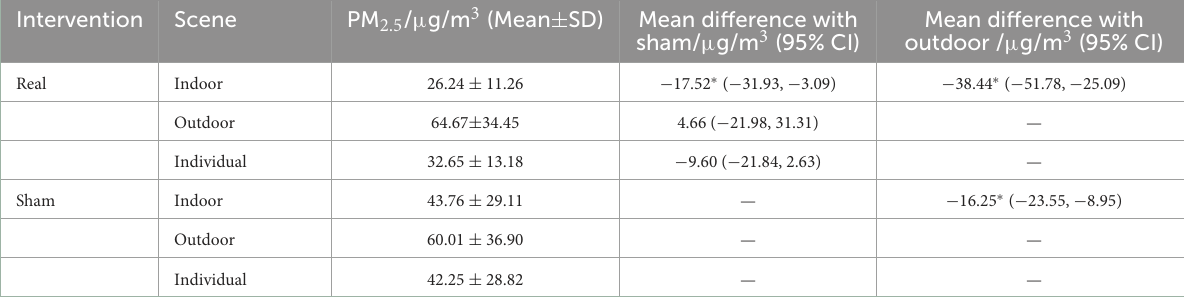
TABLE 2 Comparison of indoor, outdoor and individual exposure to PM 2.5 concentrations. Intervention